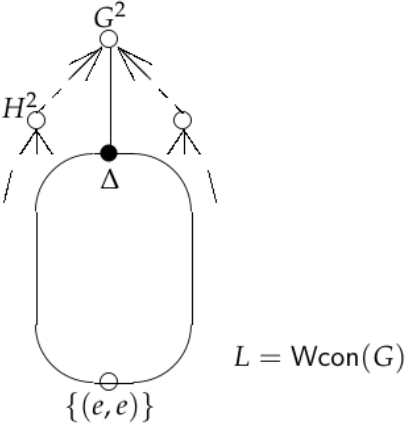
Figure 4. The weak congruence lattice of a finite simple group.